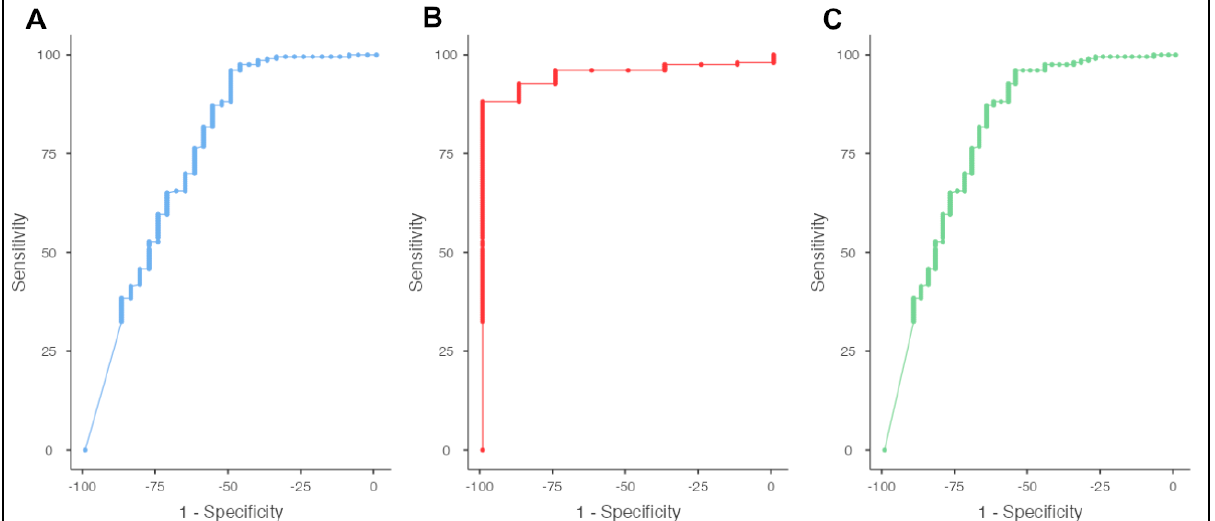
Figure 3. ROC curve analysis of SIGLEC-1 in SSc patients vs. SLE patients ( A ), SSc patients vs. MCTD patients ( B ), and SSc patients vs. SLE or MCTD patients ( C ).